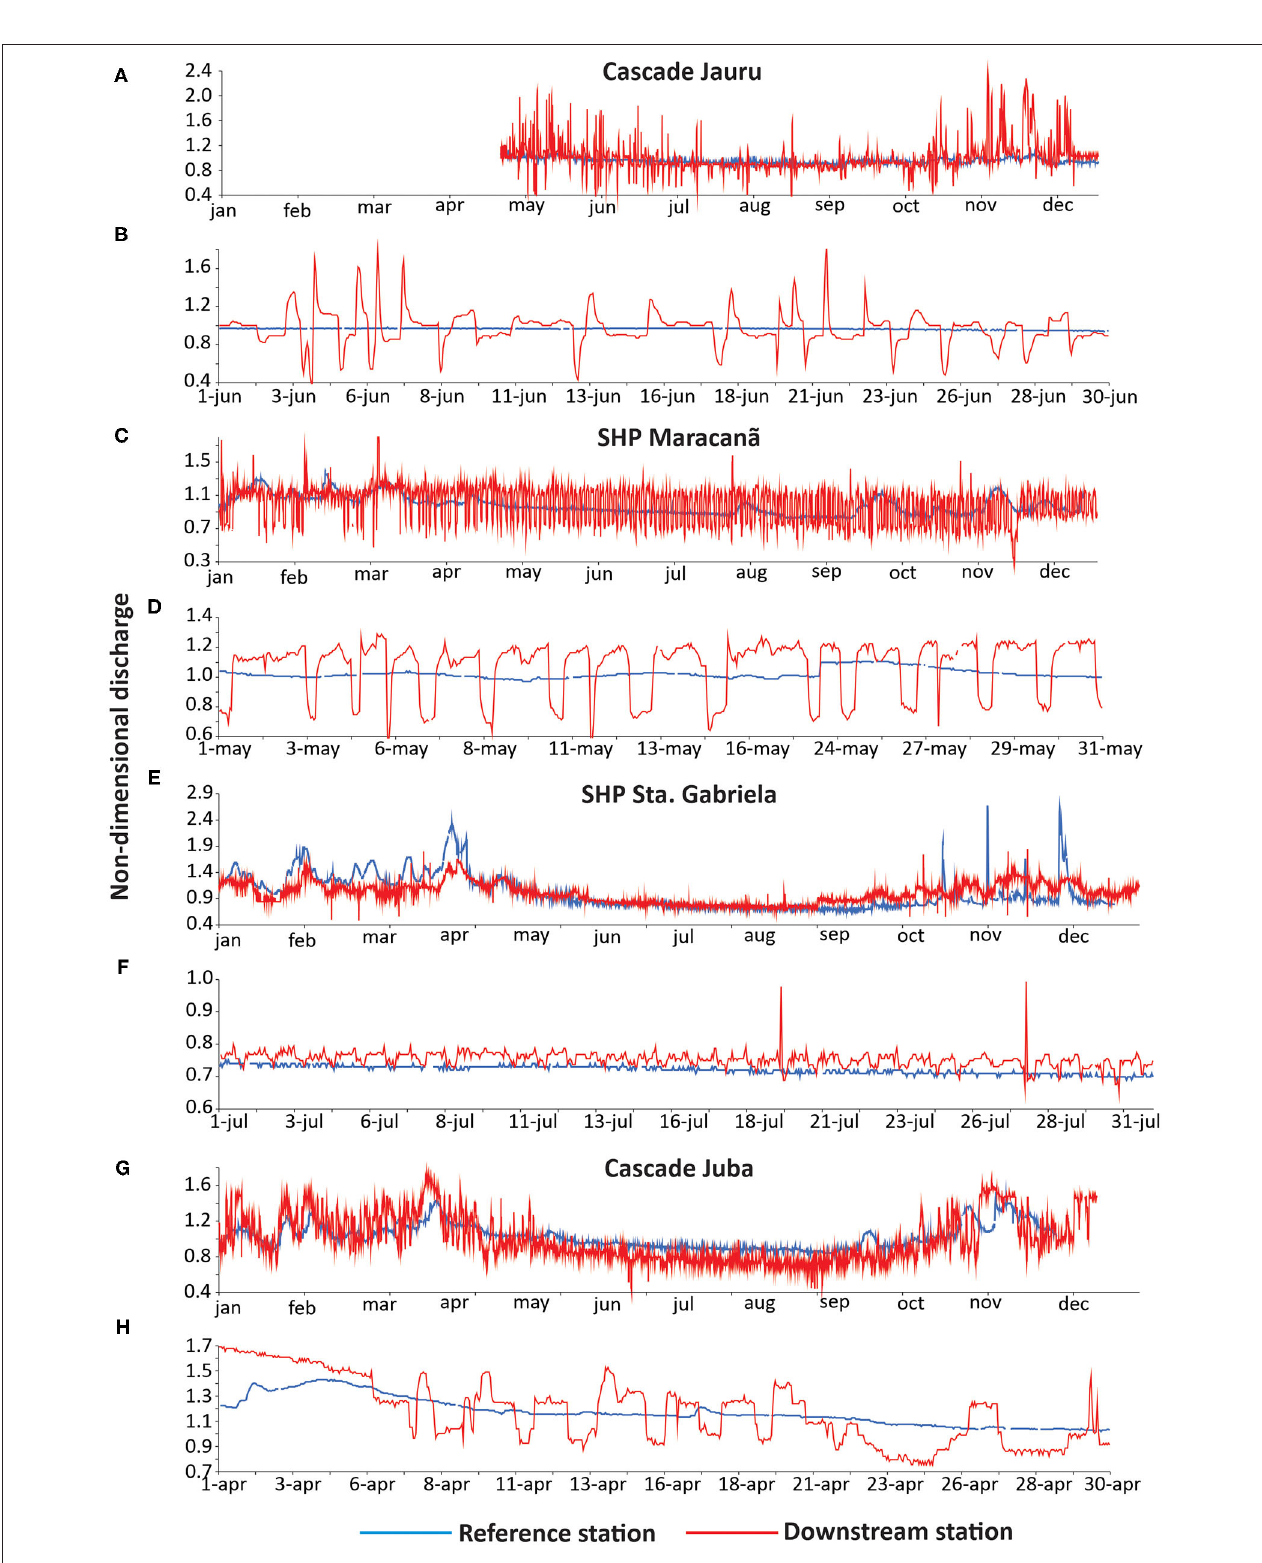
FIGURE 2 | Hydrographs showing examples of hydrological alteration by small hydropower (SHP) facilities during the 2018 calendar year (2017 for Maracanã) and in representative months of that year during the season of lower discharge. Red lines show discharge downstream of the hydropower facilities and blue lines show the reference discharge station. All discharge data are standardized to the mean annual discharge to facilitate comparisons among rivers. (A,B) Cascade Jauru on the Jauru River in Mato Grosso State; (C,D) SHP Maracanã on the Córrego Maracanã (a tributary of the Sepotuba River); (E,F) SHP Santa Gabriela on the Correntes River; and (G,H) Cascade Juba on the Juba